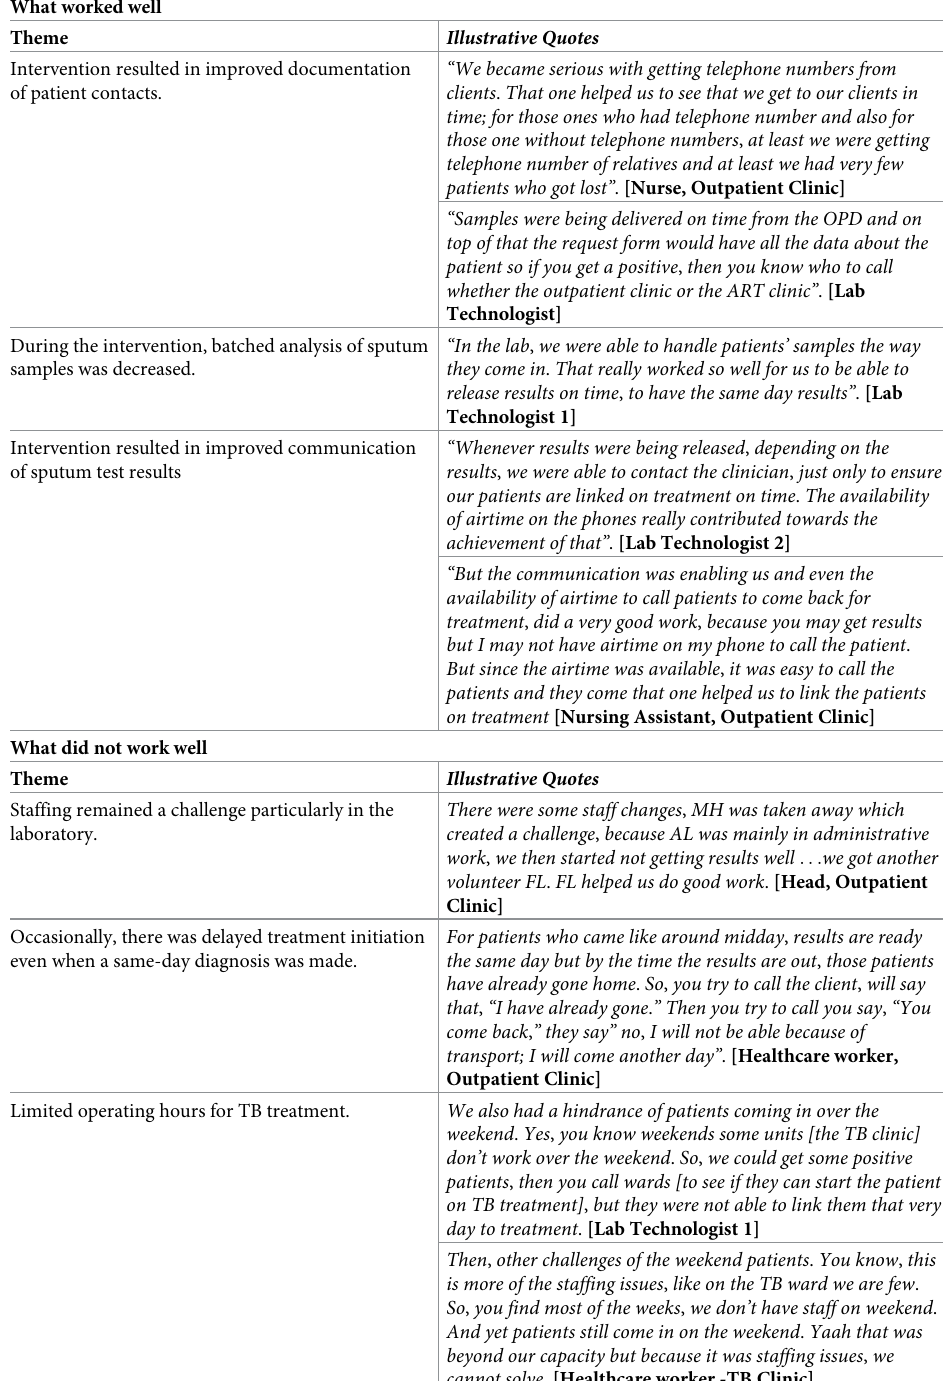
Table 4. Key themes emerging from qualitative